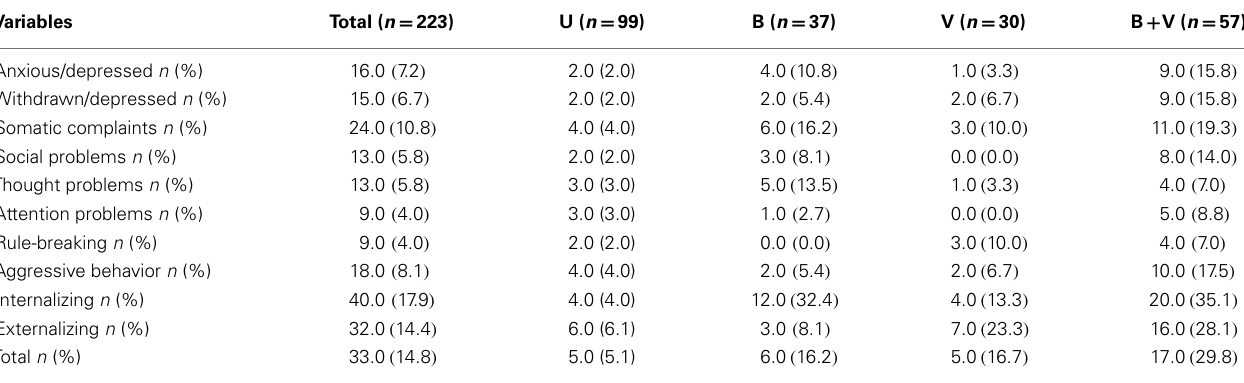
Table 3 | Prevalence of psychosocial and behavioral problems classified